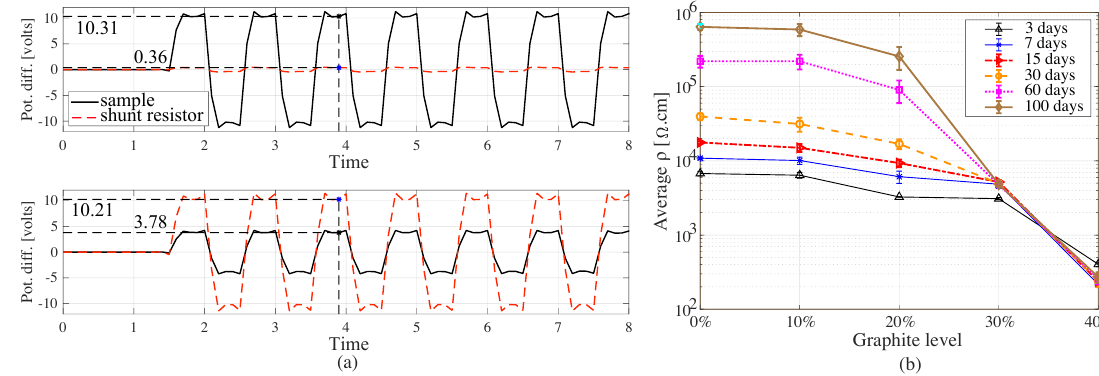
Figure 6. ( a ) Time series of potential difference (pot. diff.) from shunt resistor and the 20% (top) and 30% (bottom) graphite samples along with voltage values read from the biphasic time history; and ( b ) resistivity versus curing time for samples with 0, 10, 20, 30, and 40% of graphite inclusions. Figure 6b plots the average resistivity and range from three samples under each graphite concentration level at 3, 7, 15, 30, 60, and 100 days of curing time. The increase in resistivity during curing is the result of drying and chemical transformations resulting in reduced ionic